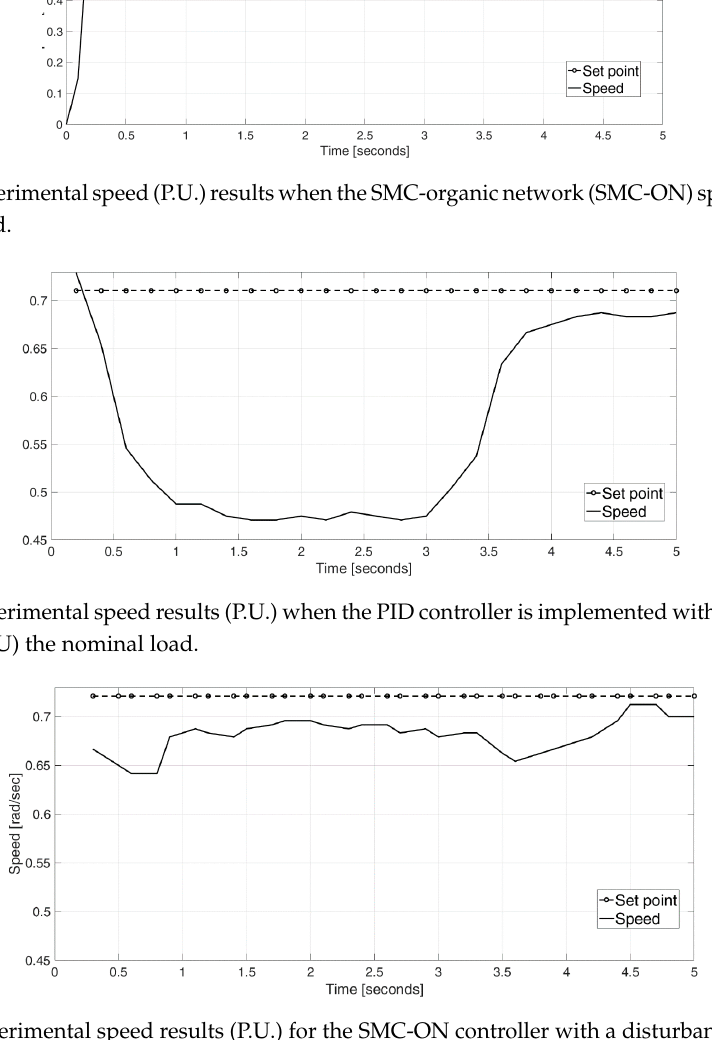
Figure 12. Experimental speed results (P.U.) for the SMC-ON controller with a disturbance of 1.5 (P.U.) times the nominal load.